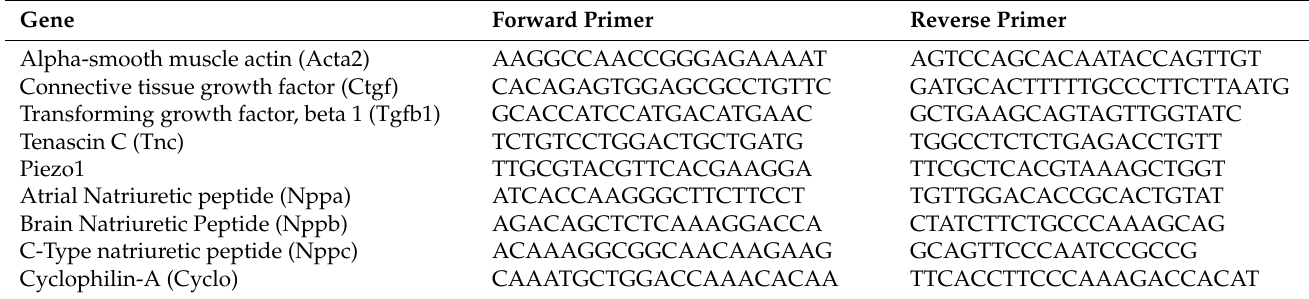
Table 1. Gene-specific primer sequences used for quantitative real-time